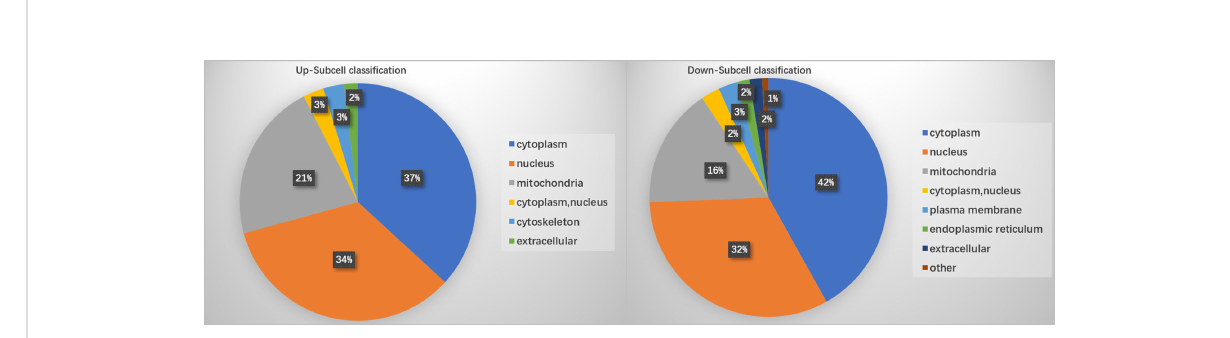
FIGURE 4 Enrichment of lactylated proteins distributed among subcellular